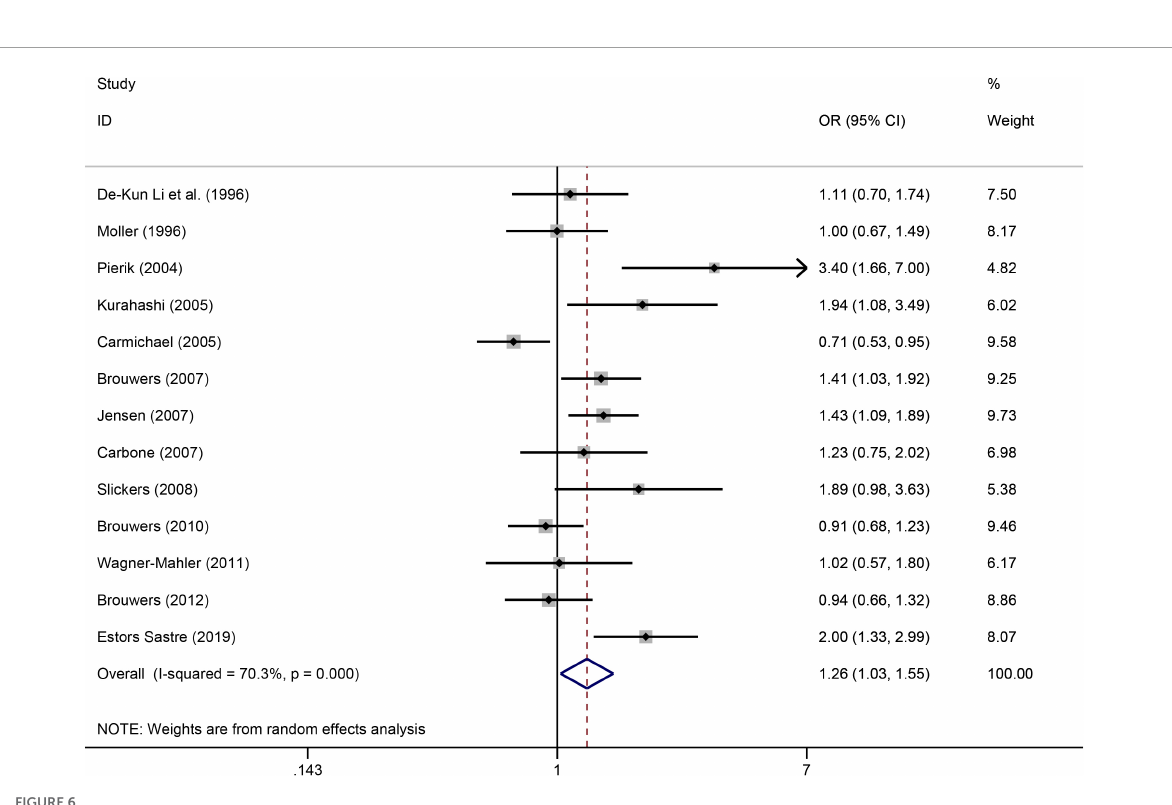
FIGURE6 Forest plot for the increased risk of congenital urogenital malformations when paternal smoking during a mother’s pregnancy. Studies were sorted by the sequence of publication